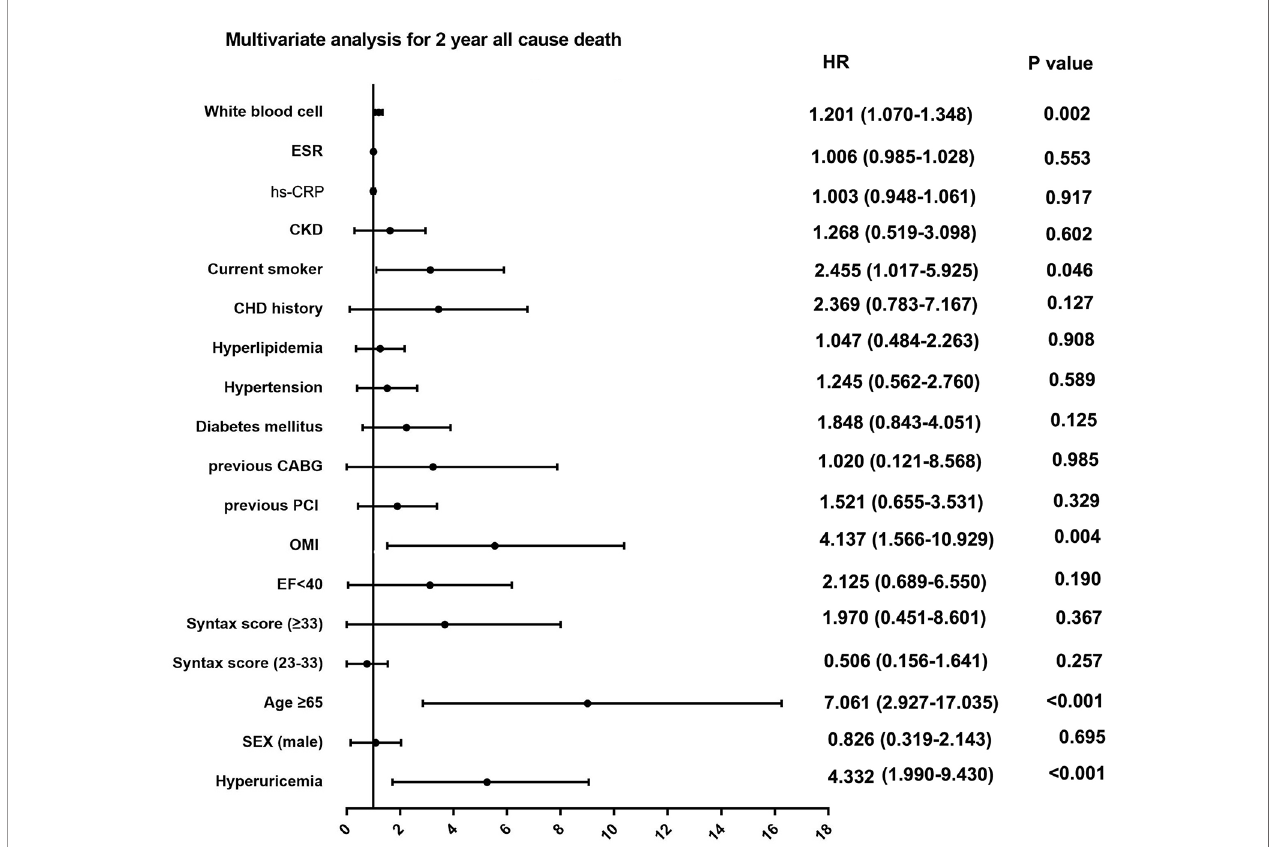
FIGURE 2 | Multivariate analysis for 2-year primary outcome in patients with STEMI. ESR, erythrocyte sedimentation rate; hs-CRP, high sensitive C-reactive protein; CKD, chronic kidney disease; CHD, coronary heart disease; CABG, coronary artery bypass grafting; PCI, percutaneous coronary intervention; OMI, old myocardial infarction; EF, ejection fraction.